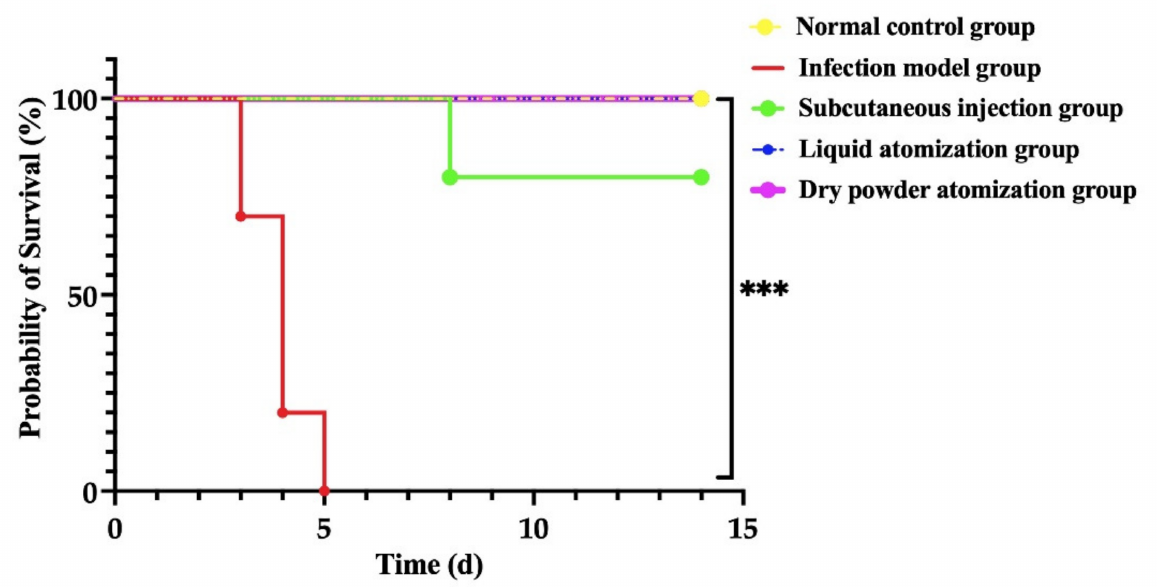
Figure 5. Survival curves for mice challenged with aerosolized Y. pestis strain 201. Mortality data were analyzed using the Kaplan–Meier survival analysis. *** p <